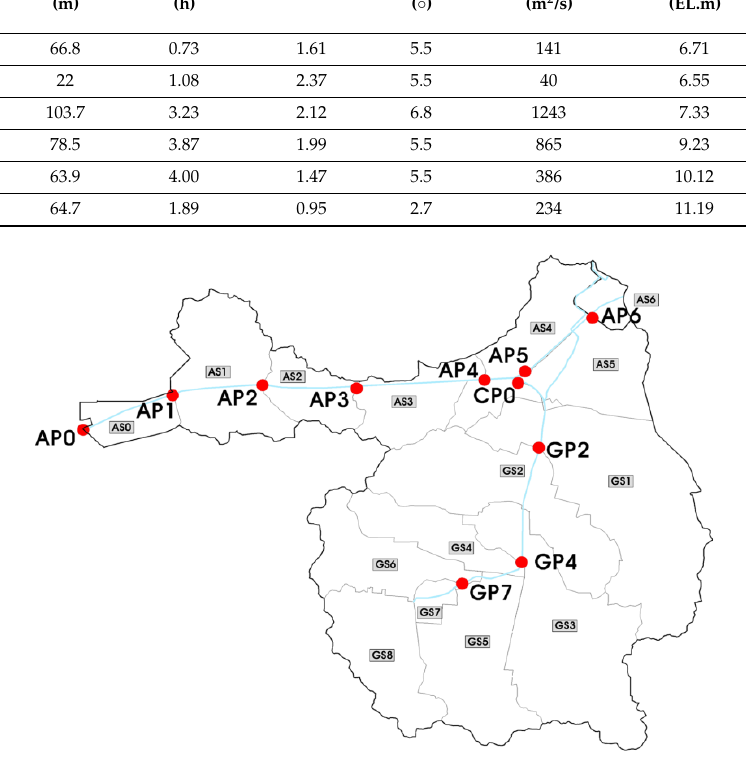
Figure 5. Sub-watershed of Gulpo and Ara Stream. Table 1. Summary of Main Input Data.